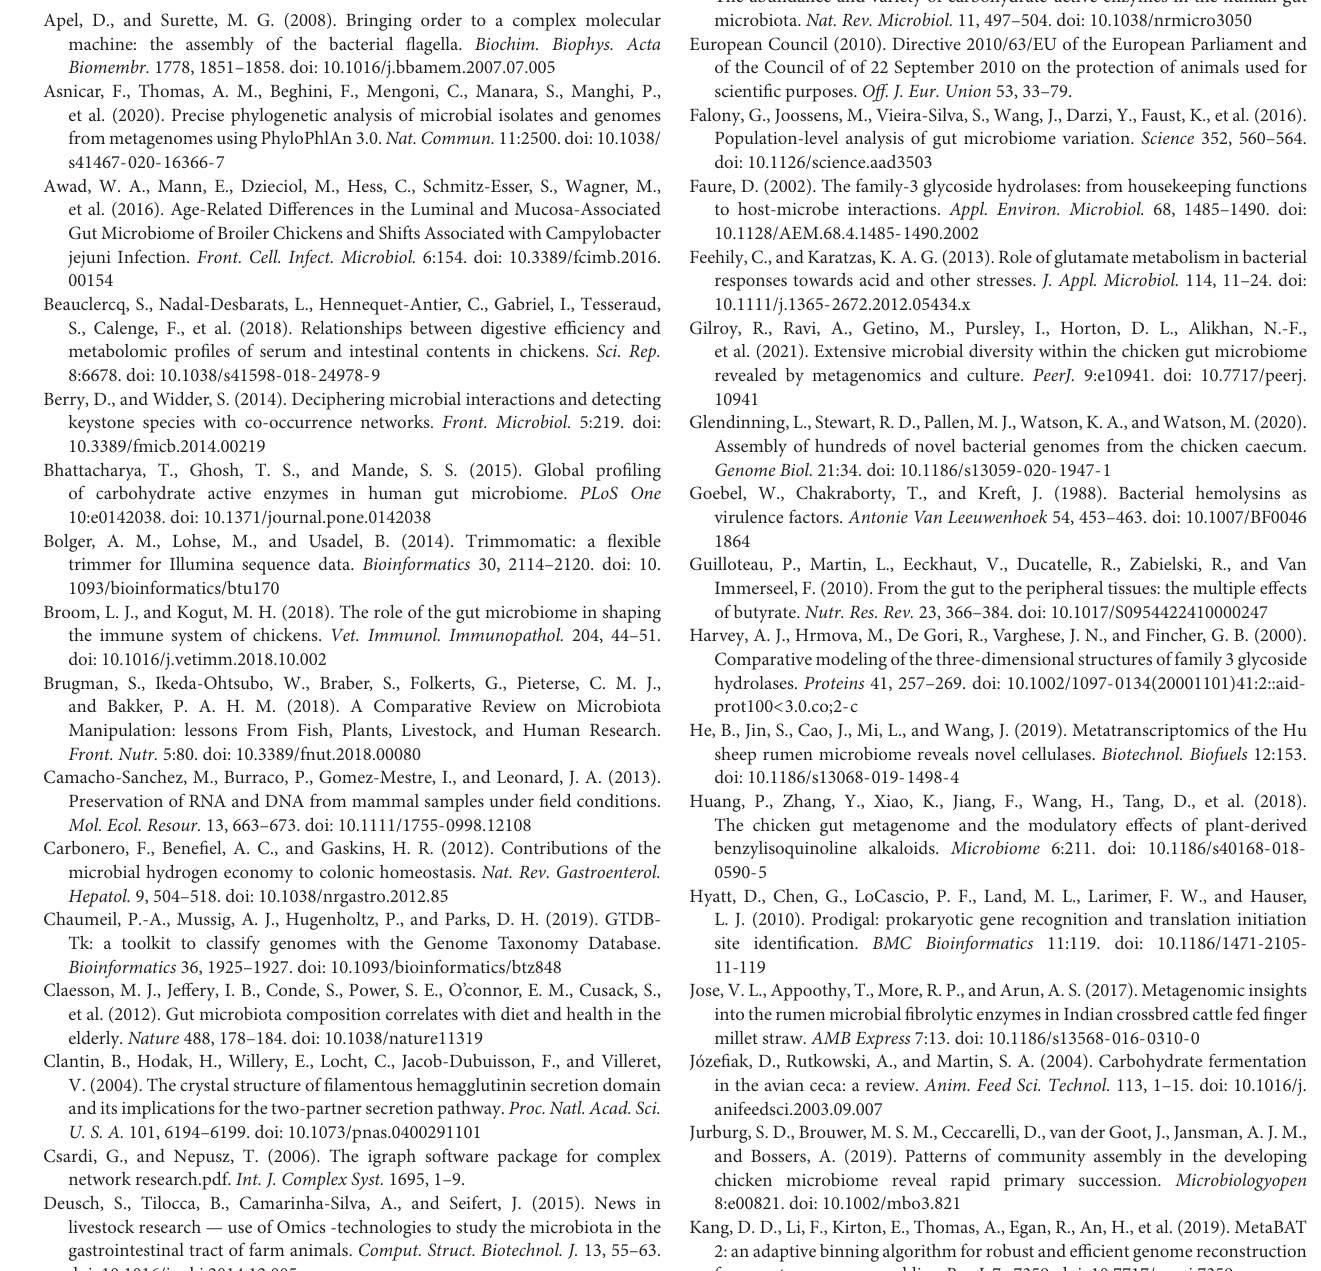
Supplementary Table 2 | General characteristics of MAGs, including completeness and contamination percentage based on CheckM, genome length, number of scaffolds, and scaffold N50. Supplementary Table 3 | Taxonomic assignments for the MAGs.